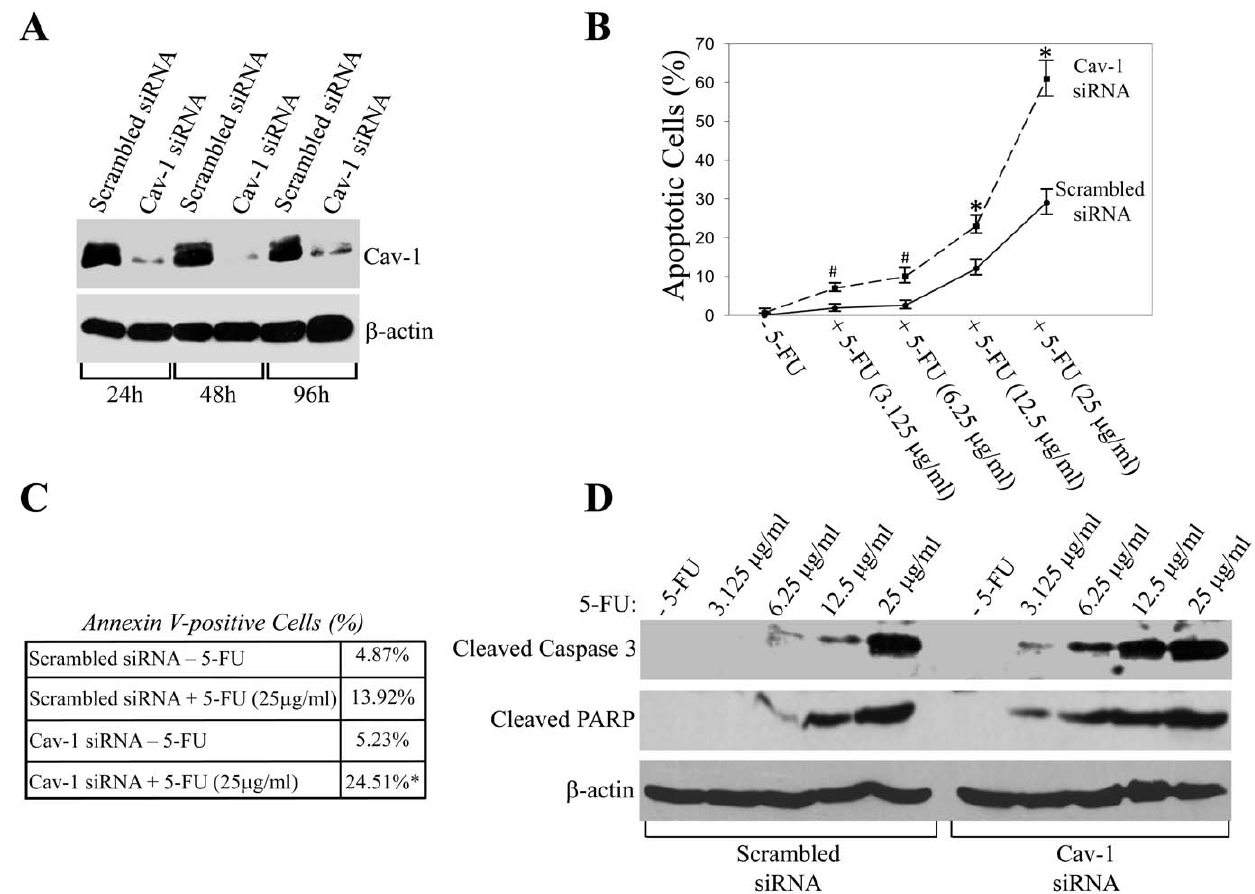
Figure 1. Knockdown of caveolin-1 protein expression sensitizes HCT116 colon cancer cells to apoptosis. HCT116 colon cancer cells were transfected with siRNA directed against caveolin-1. Transfection with scrambled siRNA was used as control. ( A ) Endogenous caveolin-1 expression was determined by immunoblotting analysis 24, 48 and 96 hours after transfection using an antibody probe specific for caveolin-1. Immunoblotting with anti- b -actin IgGs was done to show equal loading. ( B–D ) One day after transfection, HCT116 cells were treated with different concentrations of 5-FU for 48 hours. Untreated cells were used as control. In ( B ), cells were stained with DAPI and the number of cells showing nuclear condensation was quantified. Values represent mean 6 SEM; * P , 0.001; # P , 0.005. In ( C ), cells were subjected to Annexin V staining and flow cytometry. Values represent mean. In ( D ), cells were subjected to immunoblotting analysis with antibody probes specific for cleaved caspase 3 and PARP. Immunoblotting with anti- b -actin IgGs was done to show equal